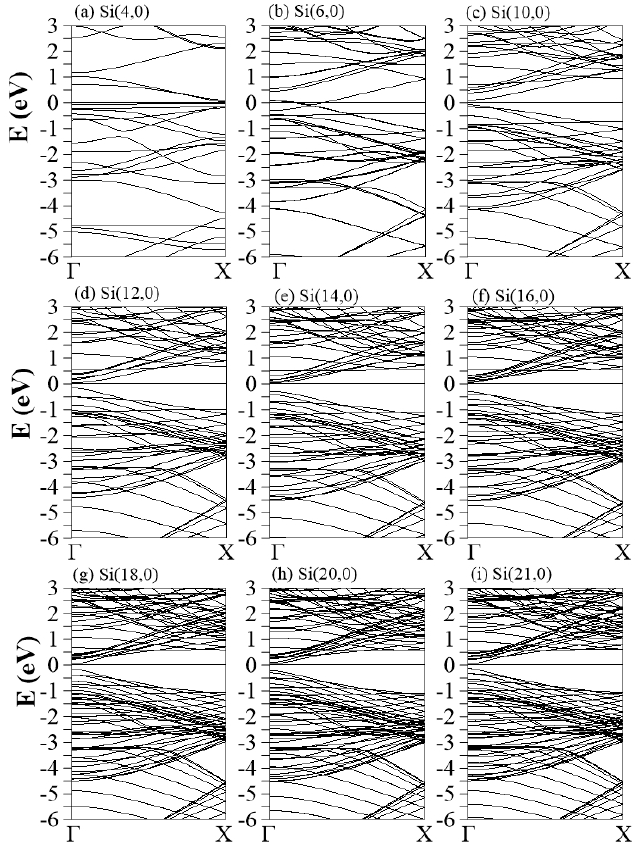
Figure 3. Band structures of zSiNTs with different chiral vectors: ( a ) (4,0), ( b ) (6,0), ( c ) (10,0), ( d )